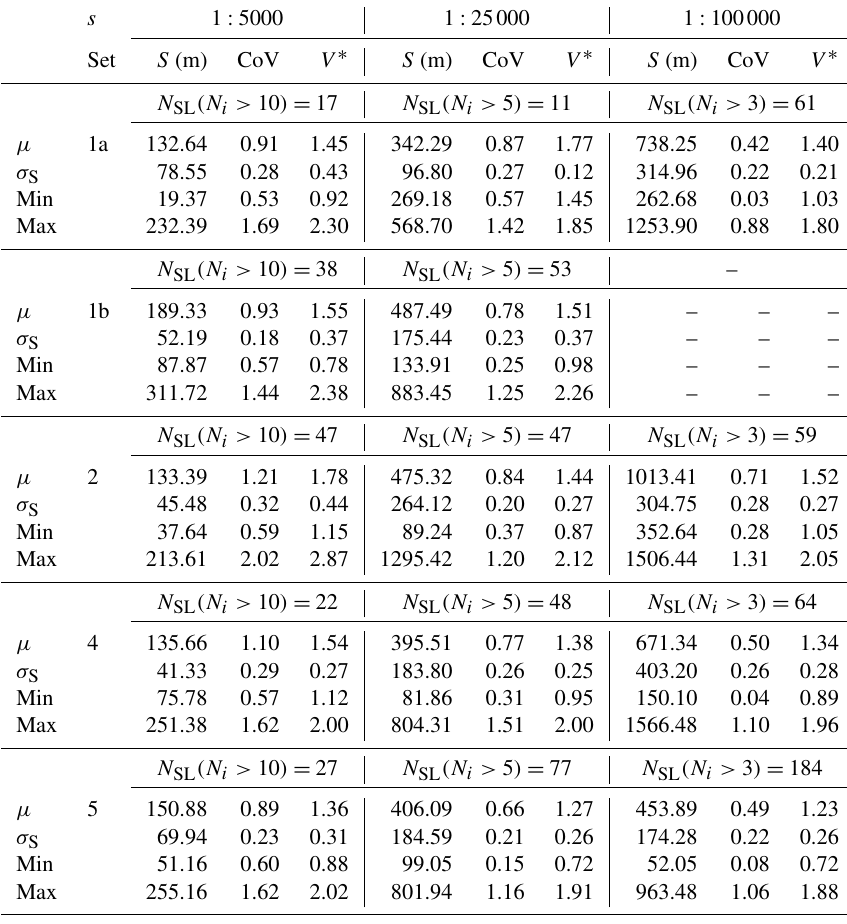
Table 4. Spacing, CoV, and V ∗ statistical parameters. The table reports the mean ( µ ), the standard deviation ( σ S ), the minimum and maximum values of spacing ( S ), CoV, and V ∗ obtained from scanline statistical